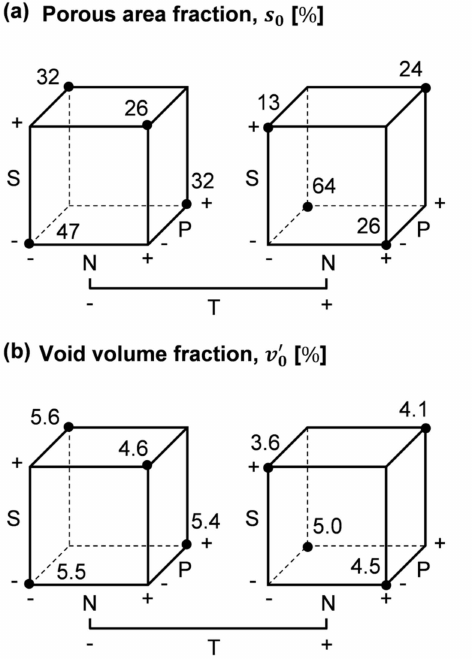
Figure 14. Cube plots of the input data of the screening experiment: ( a ) Porous area fraction, s 0 ; ( b ) Void volume fraction, v (cid:48) 0